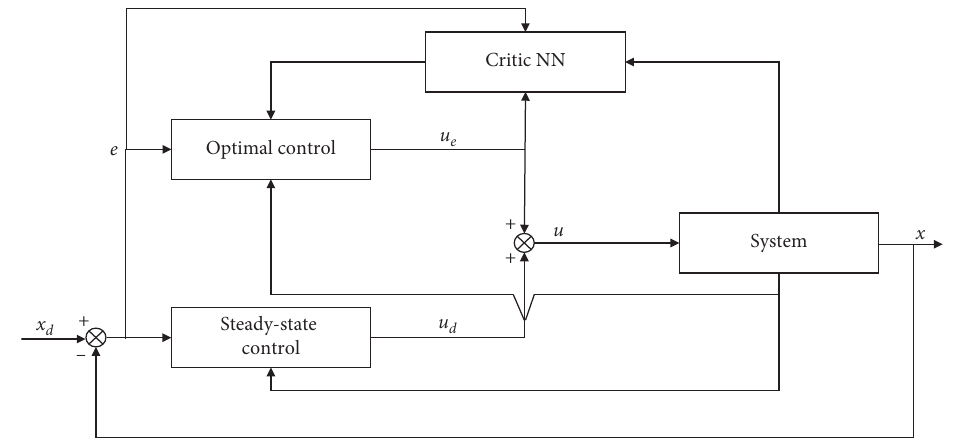
Figure 1: Schematic of the proposed control